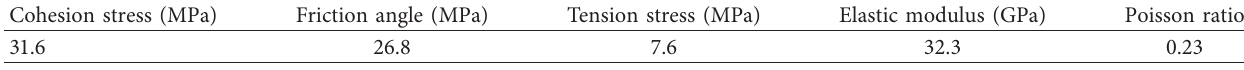
Table 1: Physical and mechanical parameters of shale.